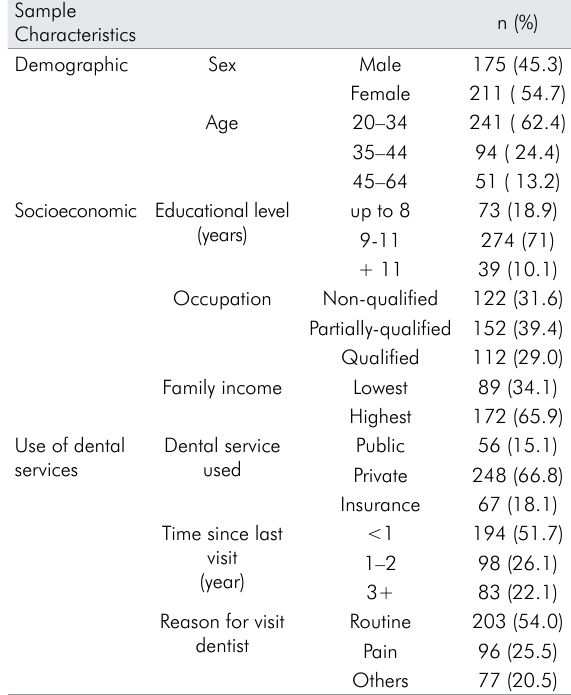
Table 1. Sample characteristics, Sao Paulo, Brazil, 2009.